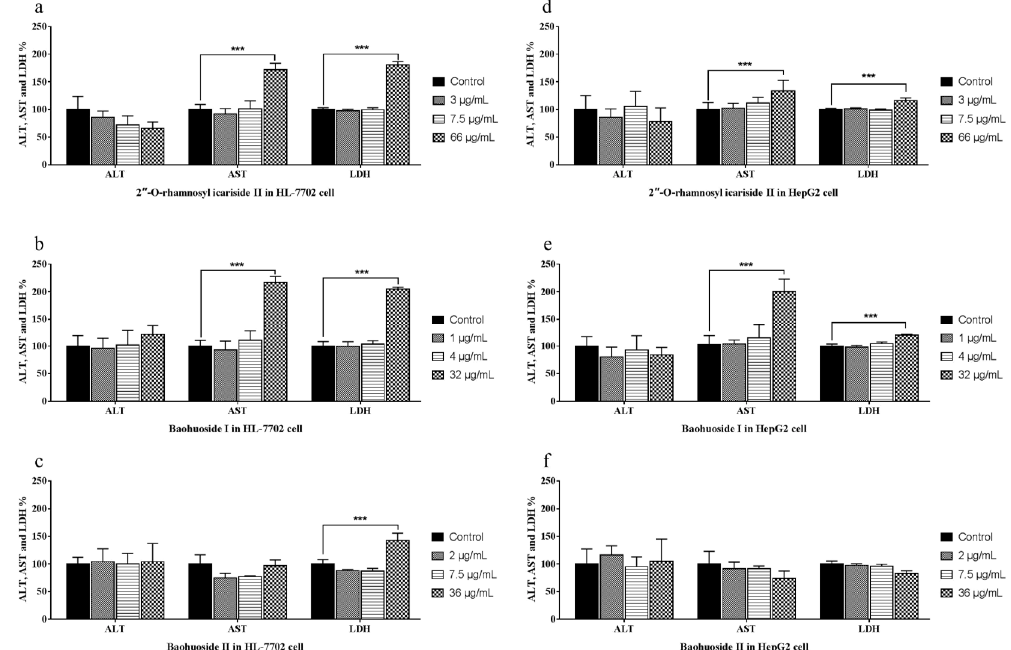
Figure 2. Effects of 2 ″ - O -rhamnosyl icariside II, baohuoside I and baohuoside II on the ALT, AST and LDH activities in HL-7702 and HepG2 cells at 24 h. Notes: The levels of ALT were not changed after treatment with three drugs at each concentration in HL-7702 ( a – c ) and HepG2 ( d – f ) cells. The levels of AST significantly increased after treatment with 2 ″ - O -rhamnosyl icariside II and baohuoside I at high concentration ( p < 0.005) in HL-7702 ( a , b ) and HepG2 ( d , e ) cells. The levels of LDH significantly increased after treatment with three drugs at high concentration ( p < 0.005) in HL-7702 ( a – c ), whereas in HepG2 cells, only 2 ″ - O -rhamnosyl icariside II and baohuoside I at high concentrations caused significant increases ( p < 0.005) ( d , e ). Each value is the mean ± SD of five experiments. * p < 0.05, ** p < 0.01, and *** p < 0.005 compared with the control group.